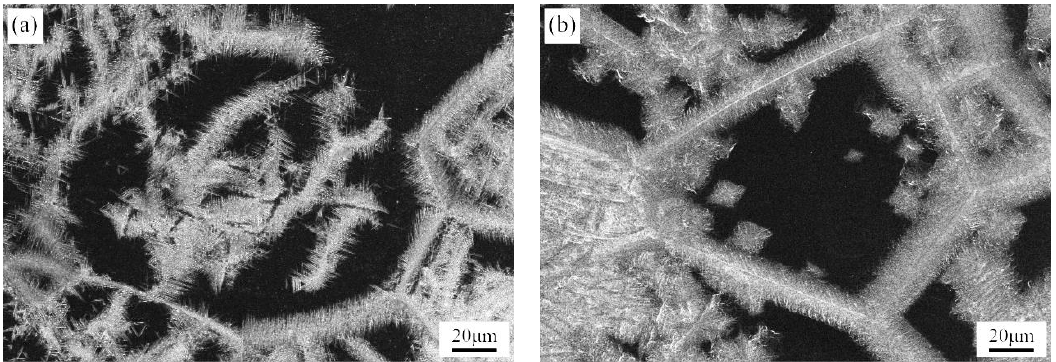
Figure 5. SEM micrograph of the alloy that was isothermally aging-treated at 500 ◦ C for 45 min after being solution-treated at ( a ) 850 ◦ C and ( b ) 1050 ◦